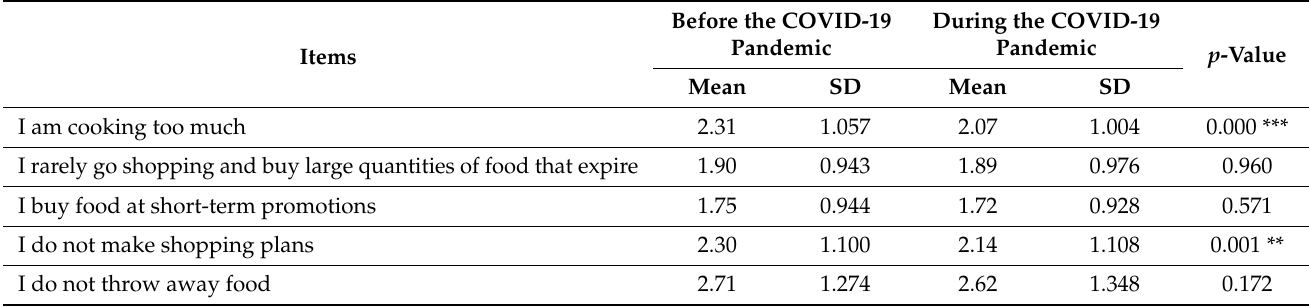
Table 4. Reasons for food discharge before the COVID-19 pandemic and during the COVID-19